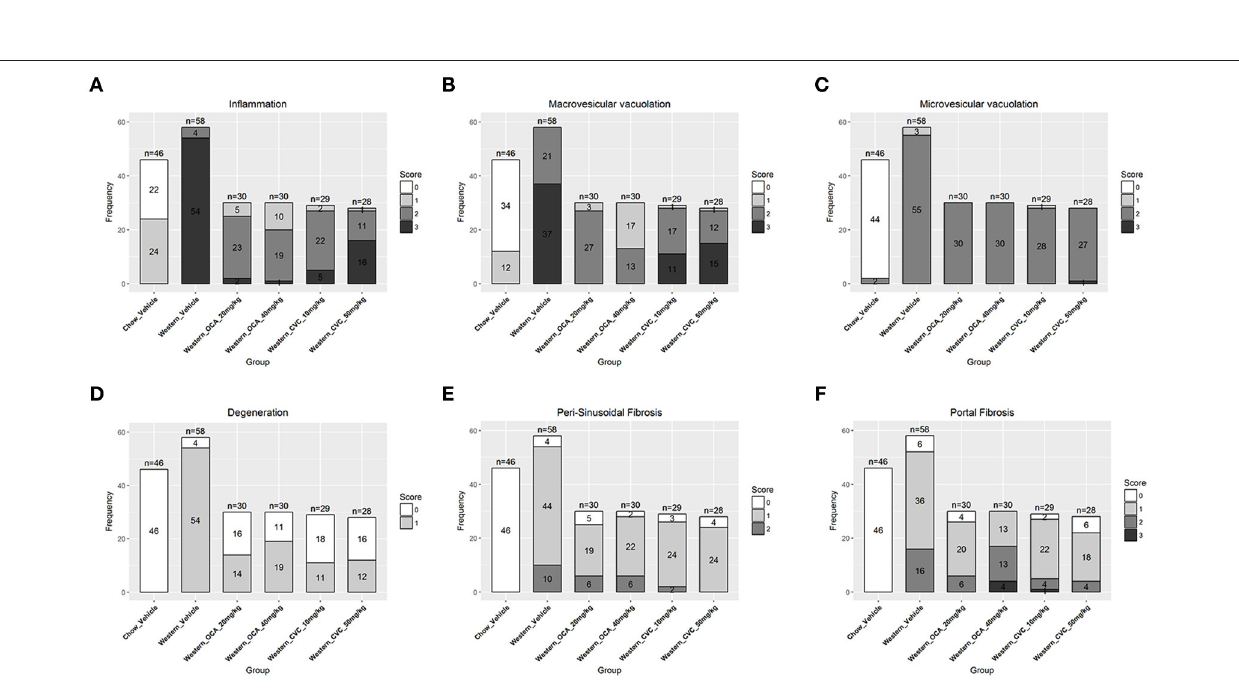
Frontiers in Pharmacology | www.frontiersin.org